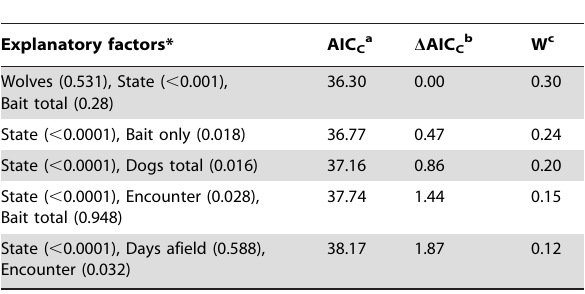
Table 1. Comparison of best performing models explaining trends in wolf depredation on bear-hunting dogs in the Wisconsin and Michigan, USA, by Akaike’s information criterion &